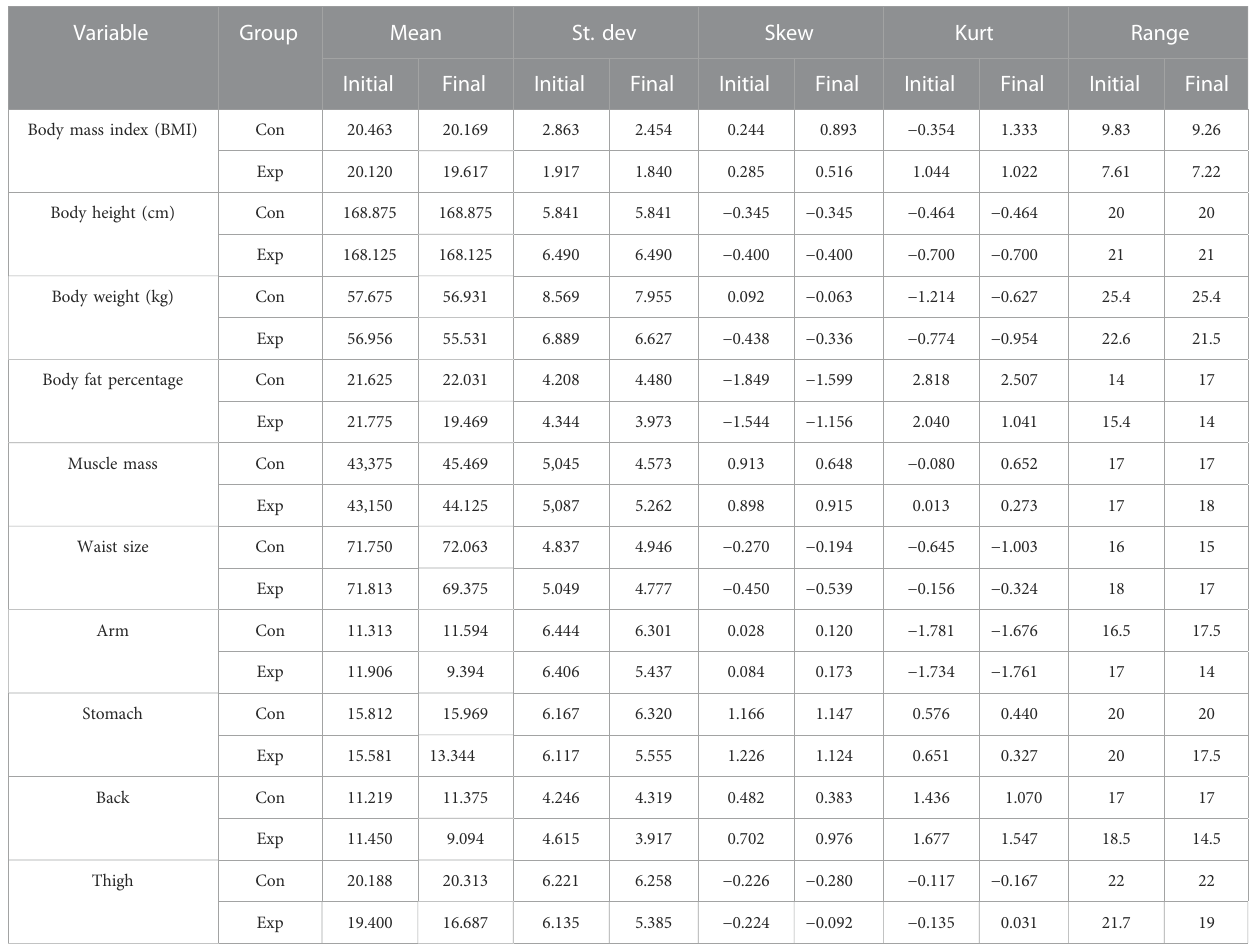
TABLE 2 Descriptive statistics of indicator variables in the initial state. Variable